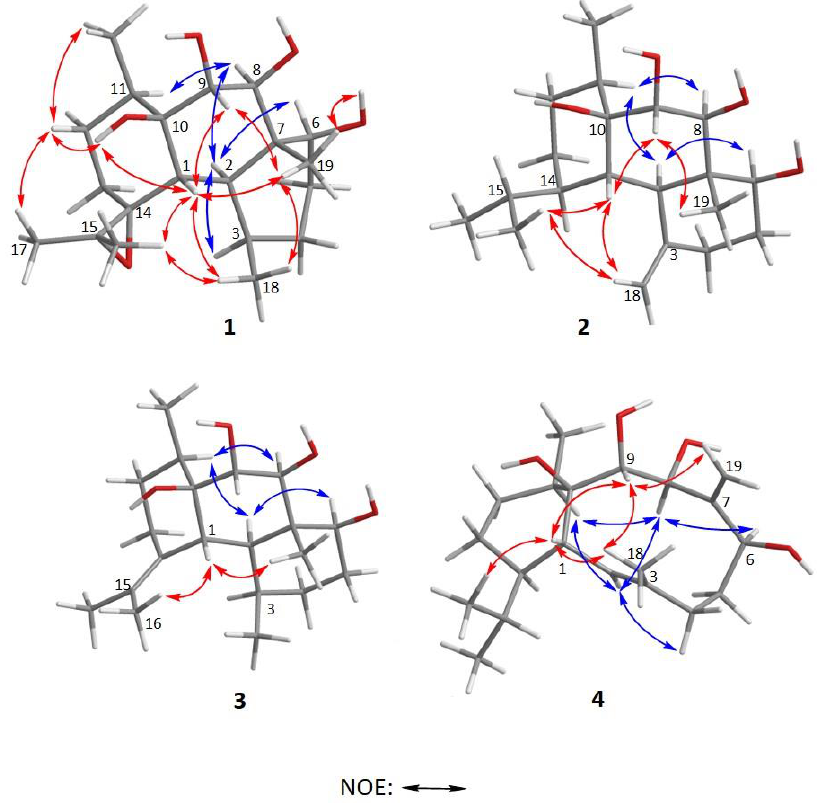
Figure 3. Selected nuclear Overhauser effect (NOE) correlations for ( 1 – 4 ).